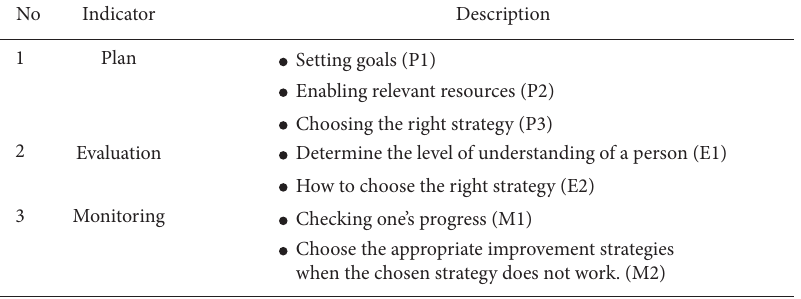
Figure 2: Indicators and descriptions of metacognitive